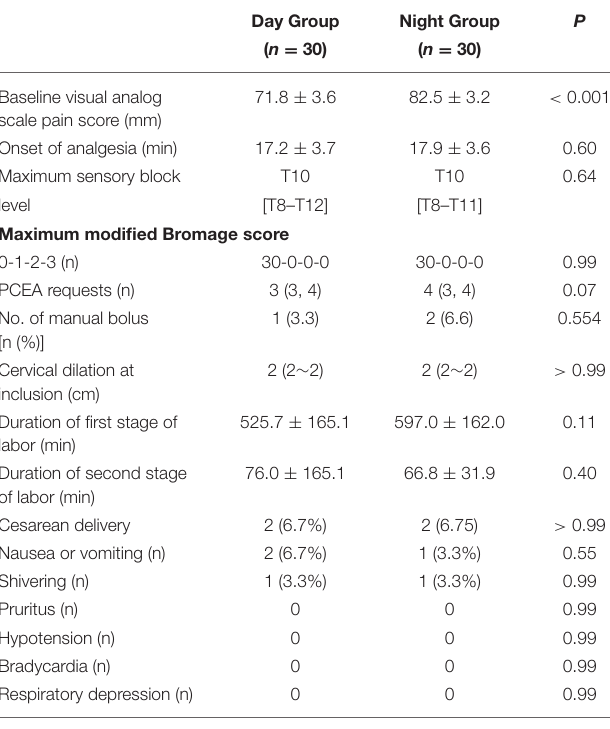
TABLE 2 | Maternal outcomes (including side effects).